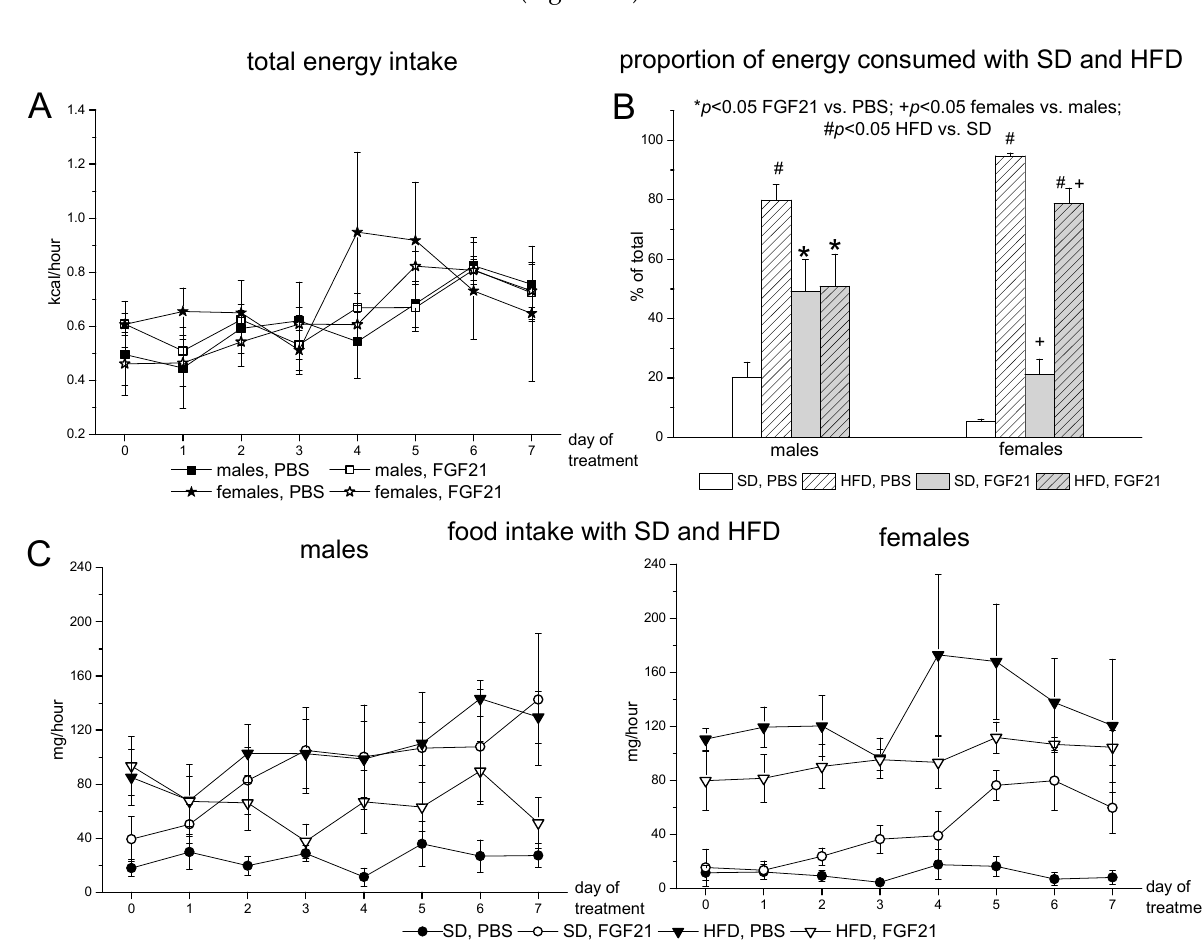
Figure 2. Influence of FGF21 administration on total energy intake ( A ), proportion of energy consumed by SD or HFD ( B ), and food intake with SD or HFD ( C ) in male and female obese mice. Data are presented as mean ± SEM. Male and female mice were fed both pelleted SD and HFD and were administered FGF21 or PBS for 7 days. Intake of energy (kcal/h) and food (mg/h) was calculated as intake per hour on average per day. The share of energy consumed by standard or high-fat diets was calculated as the 7-day average for each mouse. ( A ): p < 0.001, day of experiment, repeated measures ANOVA; ( B ): * p < 0.05, FGF21 vs. PBS; + p < 0.05, females vs. males; # p < 0.05, HFD vs. SD, Newman–Keuls post hoc test, three-way ANOVA with factors “experiment” (FGF21, PBS), “sex”, and “diet” (SD, HFD).